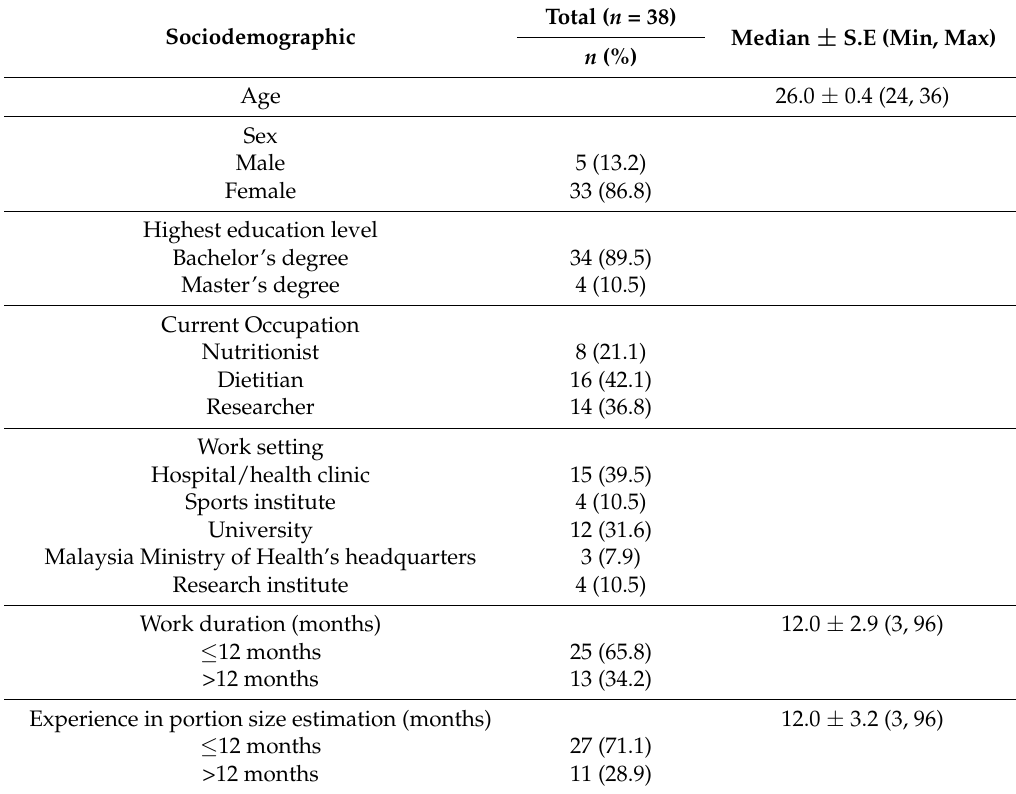
Table 1. Sample characteristics and experience in dietary assessment method.